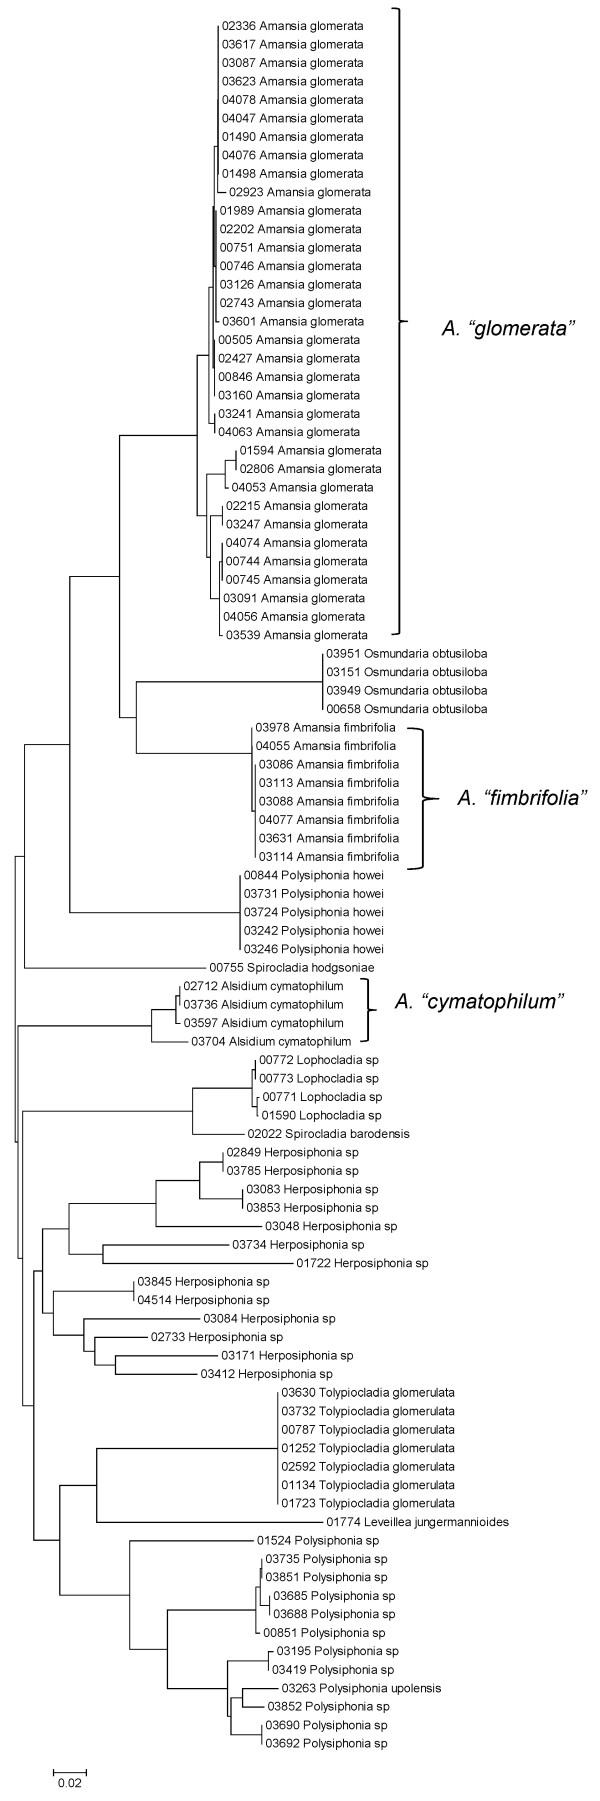
Neighbor-joining tree of COI sequences of the family Rhodomelaceae (part 2) of the order Ceramiales. Sequence diversity based on the COI mitochondrial marker for surveyed Rhodophyta specimens belonging to the family Rhodomelaceae (excluding the Laurencia complex) of the order Ceramiales. Neighbor-joining tree is based on the Maximum Composite Likelihood nucleotide model in MEGA 4.0. Scale bar = substitutions per site.